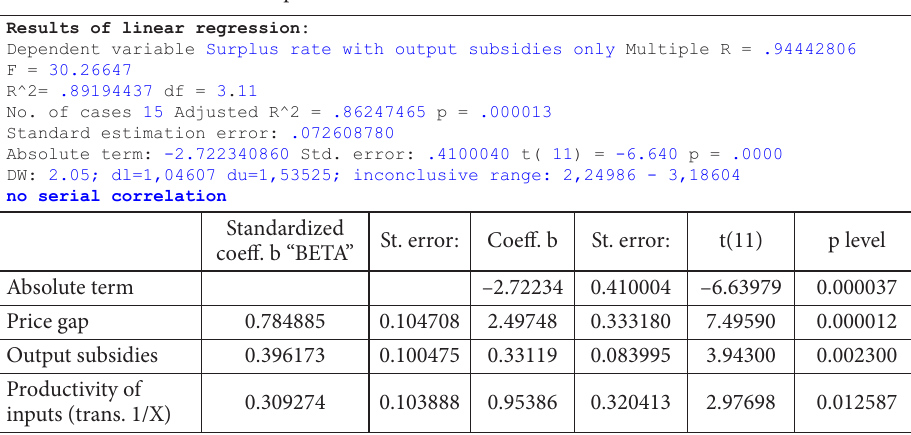
Table 8. Estimation of model 5